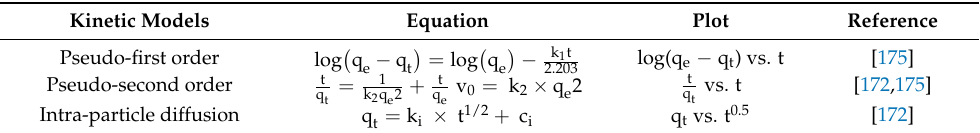
Table 4. Kinetic Models of Ammonium